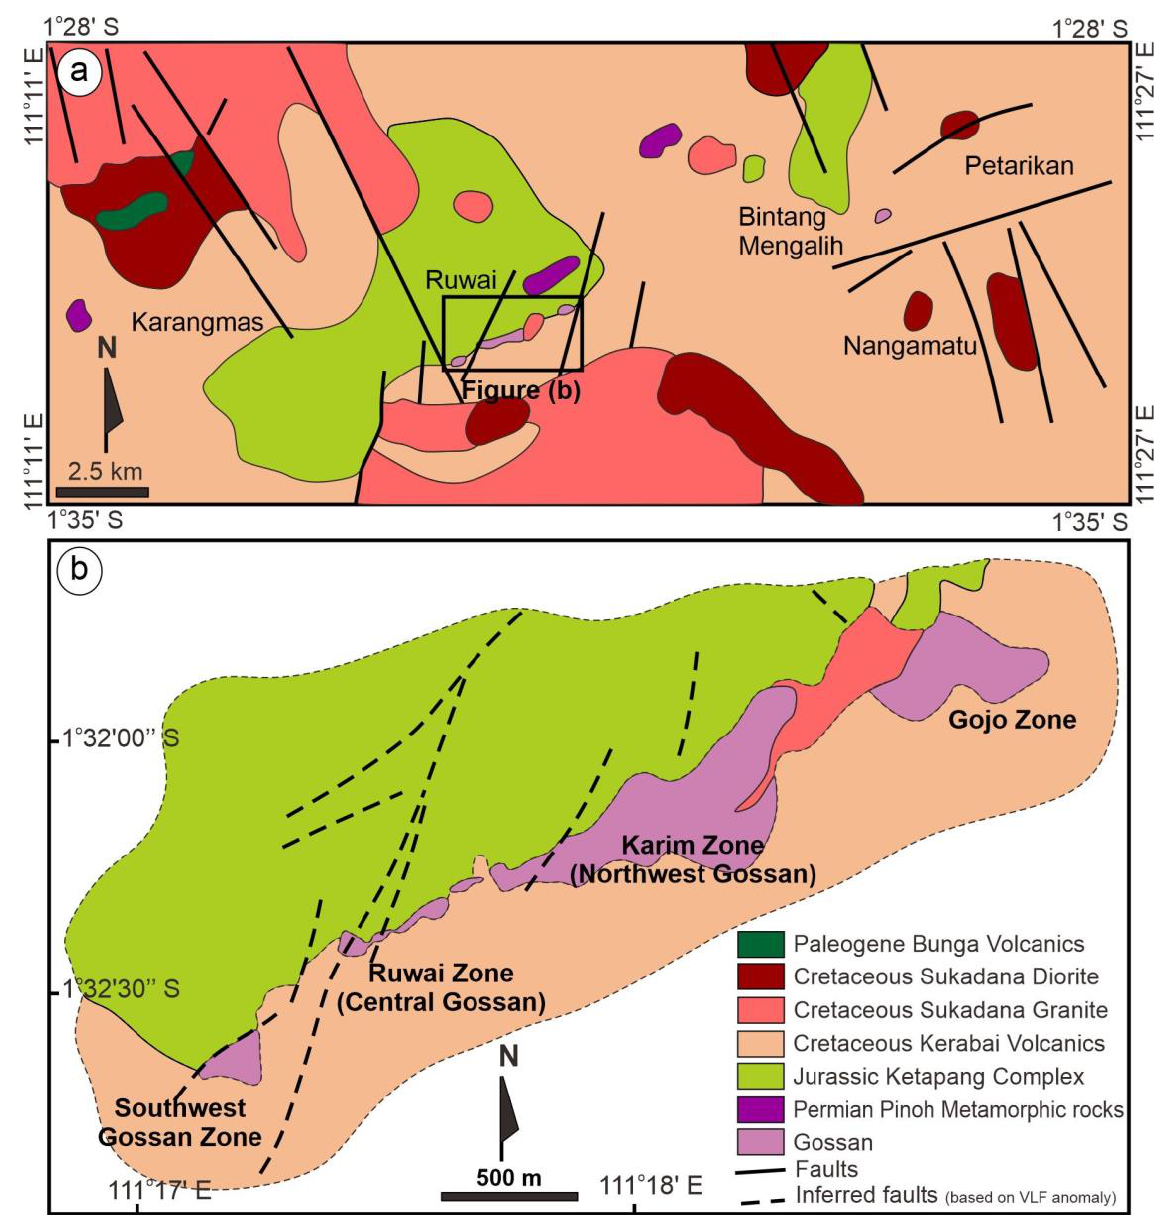
Figure 2. Simplified regional ( a ) and local ( b ) geological map of the Ruwai skarn deposit (modified after [6,9,10]).